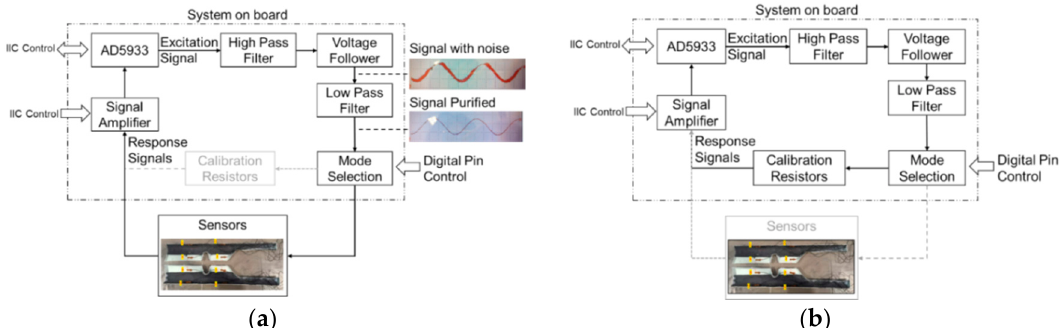
Figure 5. The circuit principle of the impedance measurement part: ( a ) Measuring mode: the mode selection part, under the control of the software by digital pin, leads the signal to the sensors. The dotted lines indicate the calibration resistors are not measured; ( b ) Calibration mode: the mode selection part leads the signal to the calibration resistors to acquire the reference signals. The dotted lines indicate the sensors are not measured.